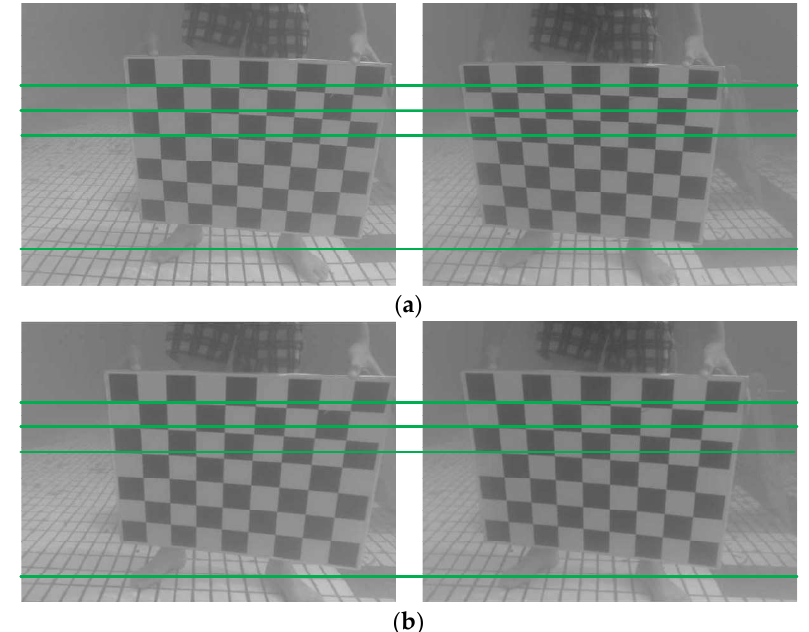
Figure 4. Comparison of the left and right images before and after correction. ( a ) The left and right images before correction; ( b ) The left and right images after correction.